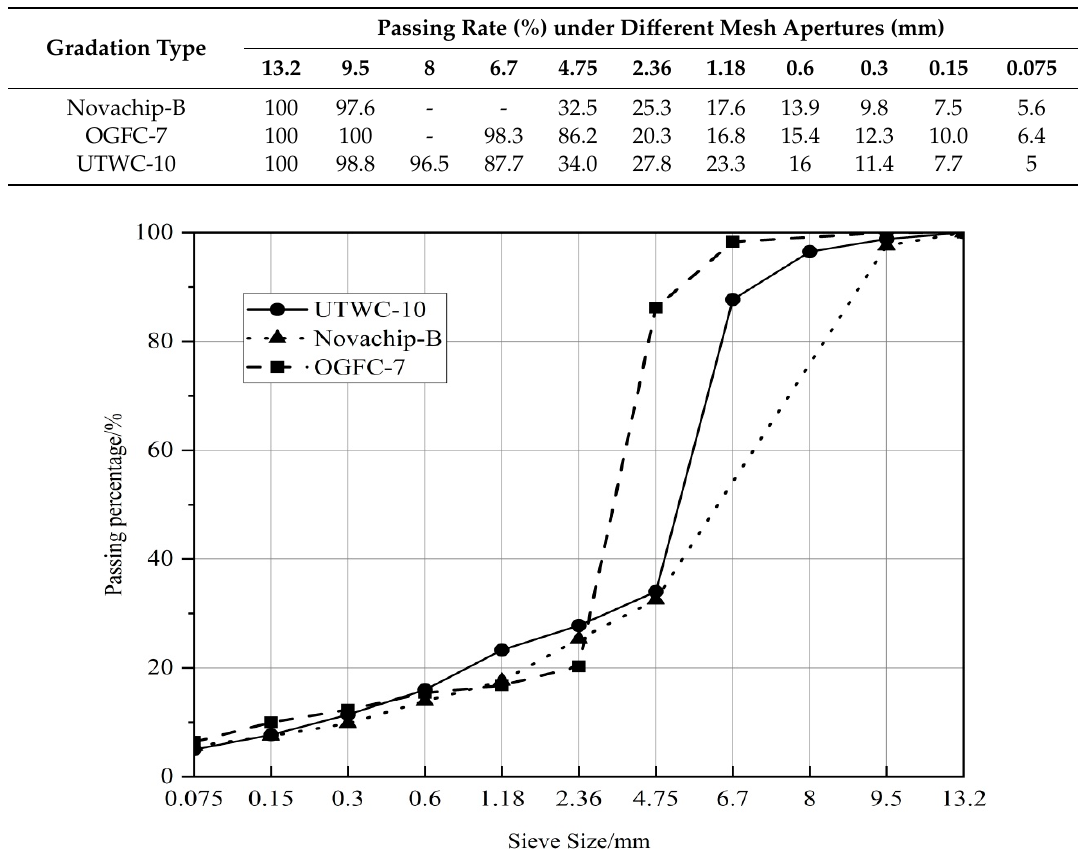
Figure 2. Flow chart of the durability test of three asphalt mixtures. Table 4. The gradation compositions of the three asphalt mixtures.